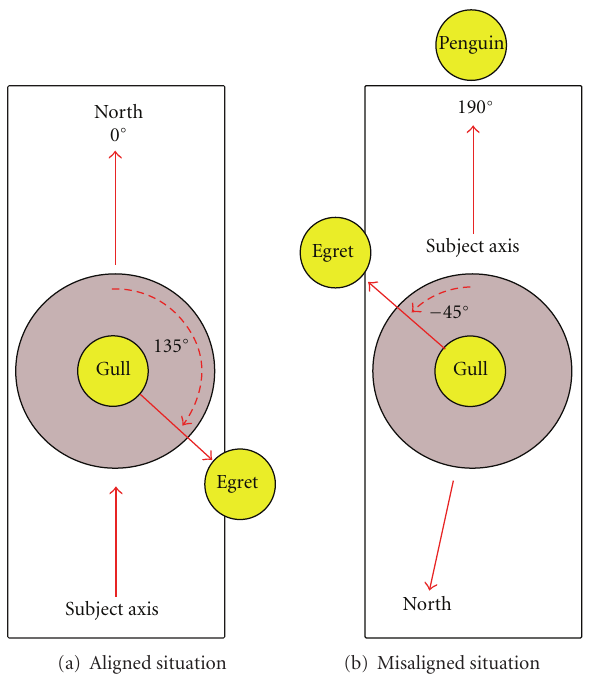
Figure 2: The use of a tactile protractor in aligned (a) and mis- aligned (b)